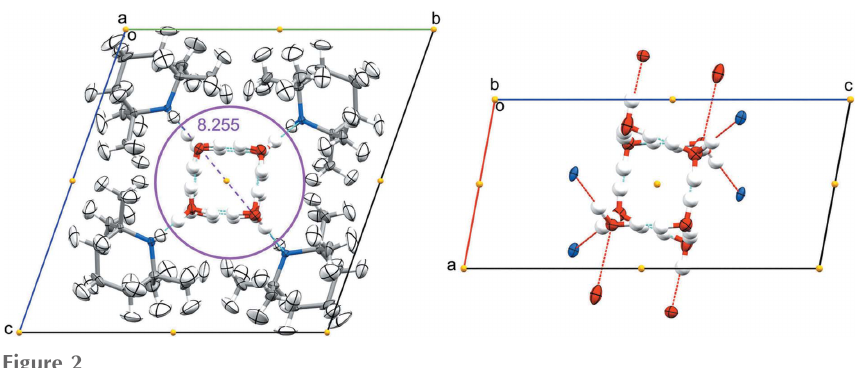
Figure 2 Structure of the water–TMP complex at 100 K from neutron-diffraction data: ( a ) a view down the a crystallographic axis, and ( b ) a view down the b crystallographic axis showing only the water cluster and the hydrogen bonding it forms. Ellipsoids are represented at 50% probability level; the purple circle indicates a diameter of (cid:3) 8.2 A˚ and the yellow dots indicate the positions of the centres of inversion in the unit